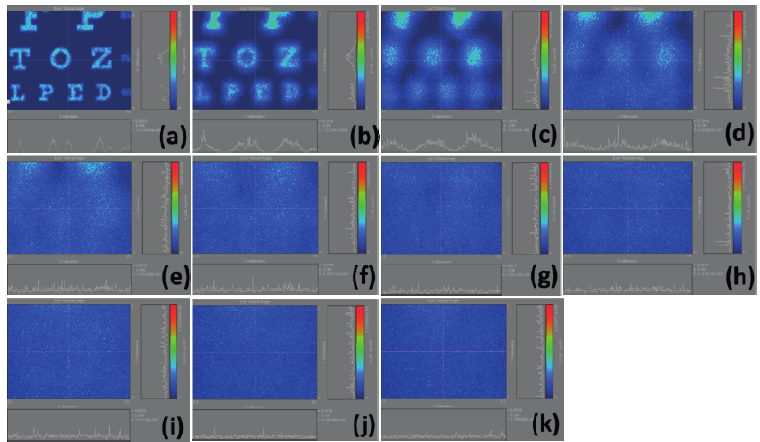
Figure 8. Calculation results of retinal images by selecting the whole Snellen chart in Figure 3(e); ( a ) plano; ( b )1.00 D; ( c ) 2.00 D; ( d ) 3.00 D; ( e ) 4.00 D; ( f ) 5.00 D; ( g ) 6.00 D;